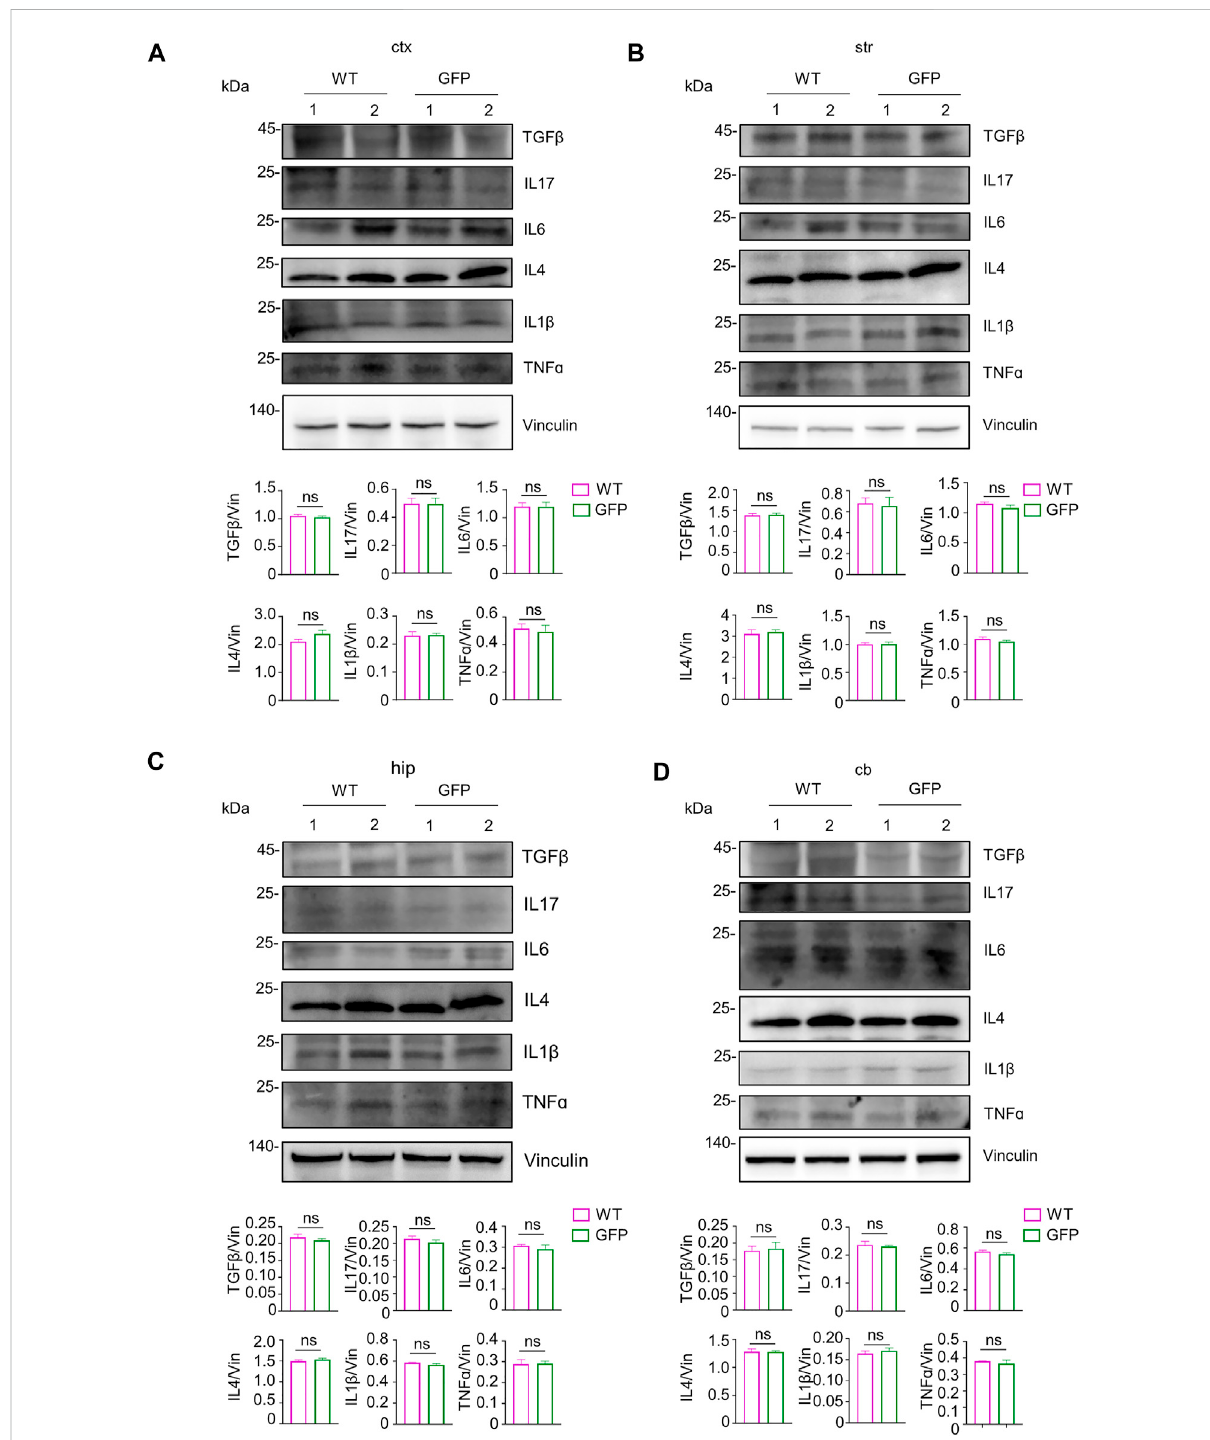
FIGURE 6 Examinationofin fl ammatoryfactorsinthepig ’ scentralnervoussystemafterintravenousinjectionofsalineorAAV-GFP. (A – D) Westernblotting ofthecorticaltissue (A) ,striatum (B) ,hippocampus (C) andcerebellum (D) ofsaline-orAAVGFP-injectedpigswithantibodiesagainst TGF β ,IL17,IL6, IL4,IL1 β andTNF ɑ .Vinculinservedasaloadingcontrol.QuantitationoftheratiosofTGF β ,IL17,IL6,IL4,IL1 β andTNF ɑ tovinculinonthewesternblots are presented beneath the blots. Data are analyzed by Student ’ s T-test and presented as mean ± SEM. n = 3 animals per